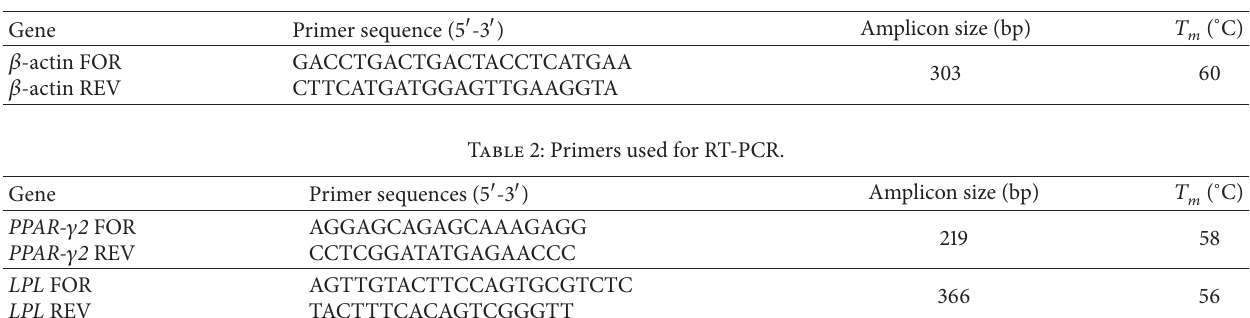
Table 1: Primers used for the 𝛽 -actin gene.